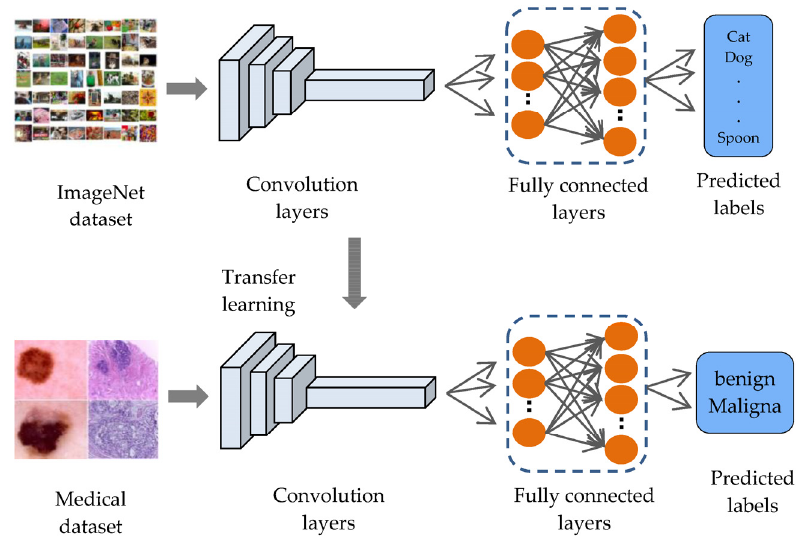
Figure 1. Transfer learning from ImageNet.